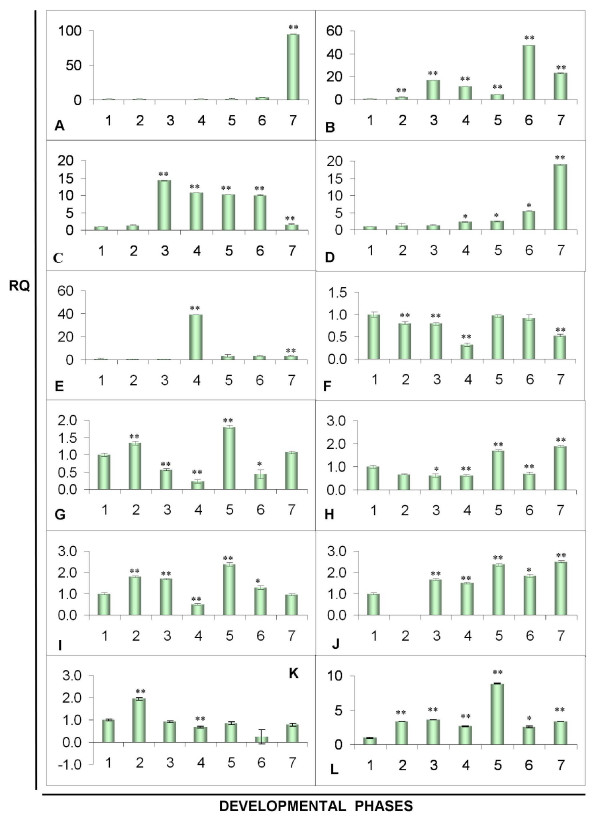
RT-qPCR of genes expressed in different phases during the culture of M. perniciosa in basidiomata-inducing medium. A – MpPRIA1; B – MpPRIA2; C – MpPLYB; D – MpRHEB; E – MpGLU; F – MpADE; G – MpCPR; H – MpRHO1-GEF, I – MpMBF; J – MpRAB; K – MpCYP; L – MpRPL18. In Y axis values of RQ using primers constructed for each gene and in axis X corresponding samples of RNA originated from mycelia in the following stages: 1 = cDNA of mycelium white stage, 2 = cDNA of yellow mycelium stage, 3 = cDNA of reddish pink mycelium stage, 4 = cDNA of reddish pink mycelium before stress, 5 = cDNA of reddish pink mycelium after stress, 6 = cDNA of mycelium with primordia and 7 = cDNA of basidiomata. RQ = relative quantification measured by ddCt. (*) – significant at 5% probability, (**) – significant at 1% probability by the statistical t test.